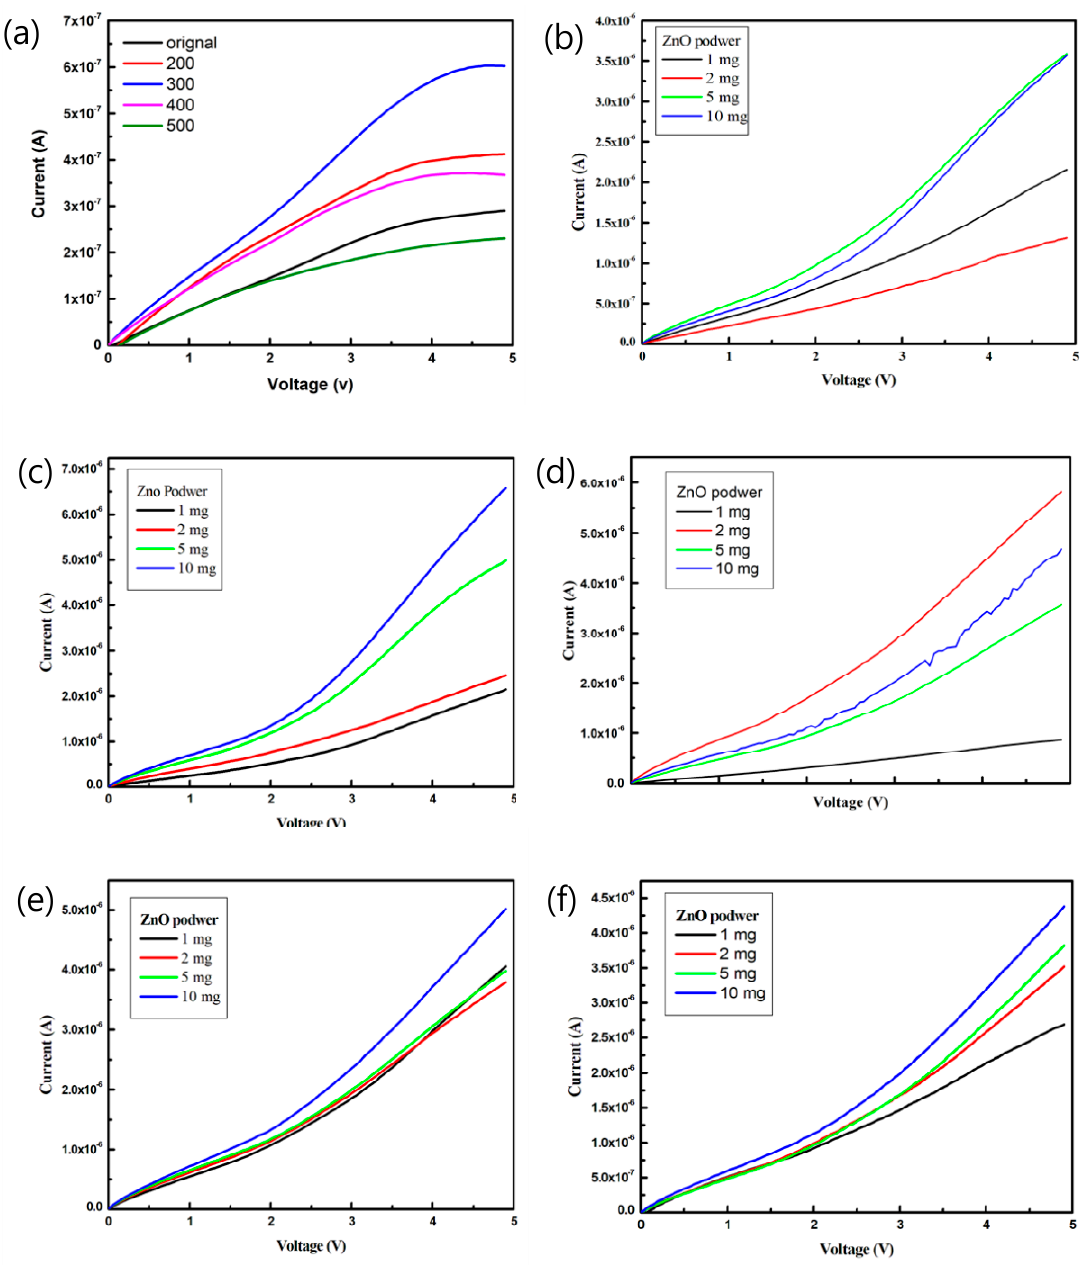
Figure 6. I–V characteristics of the pa-ZnO-doped CsPbBr 3 perovskite acetone sensors with treatment of annealing at various temperatures and pa-ZnO doping amounts: ( a ) pa-ZnO sensor, ( b ) doping pa-ZnO without anneal, ( c ) doping pa-ZnO annealed at 200 ◦ C, ( d ) doping pa-ZnO annealed at 300 ◦ C, ( e ) doping pa-ZnO annealed at 400 ◦ C, and ( f ) doping pa-ZnO annealed at 500 ◦ C. The sensitivity of the pa-ZnO-doped CsPbBr 3 perovskite acetone sensors with the treatment of annealing at various temperatures and pa-ZnO doping amounts at 4.9 V,